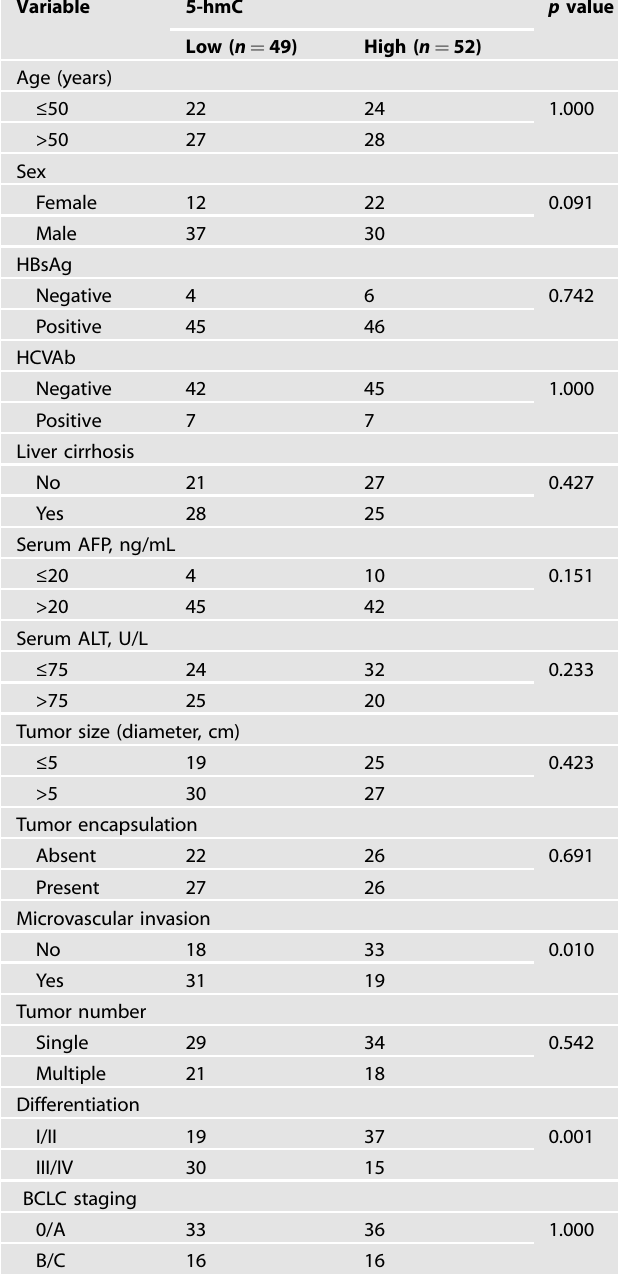
Table 1. Correlation between 5-hmC and clinicopathological characteristics in 101